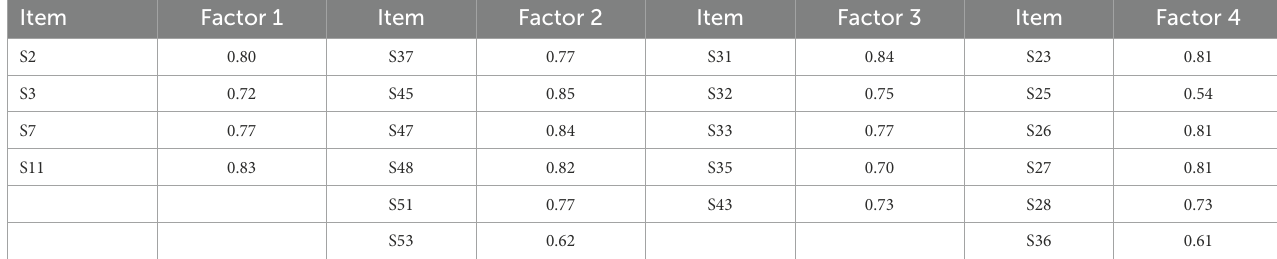
TABLE 4 Factor loading of social anxiety cognition scale for college